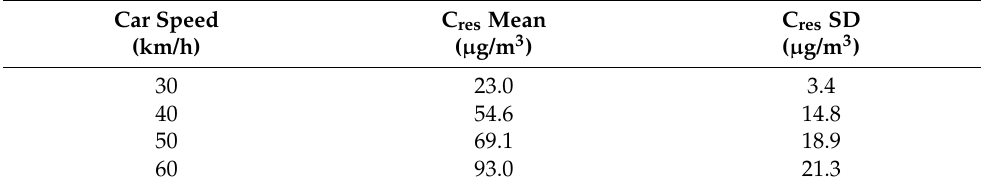
Table 2. C res concentration mean and standard deviation value measured with car speed in testbed.